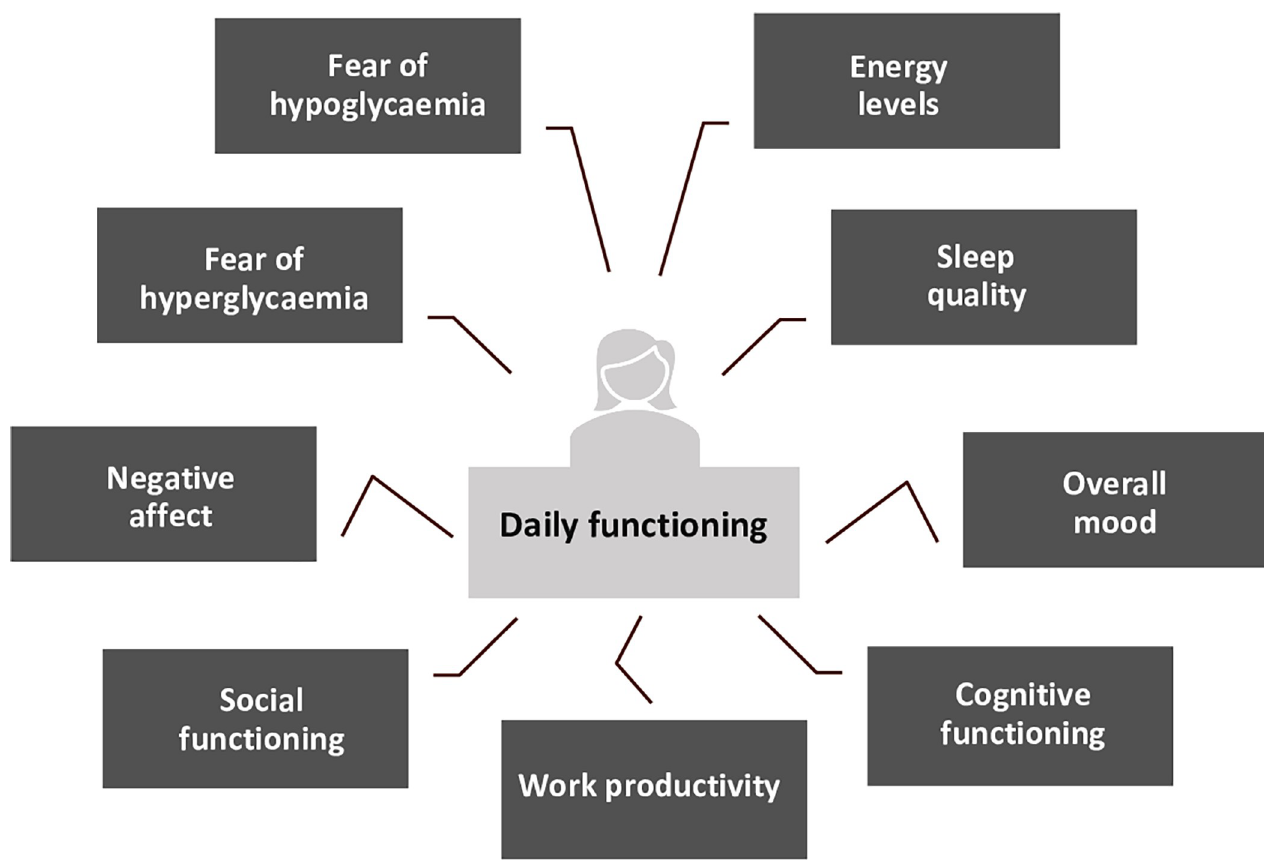
Fig 1. The overall domains of daily functioning assessed by the Hypo-METRICS